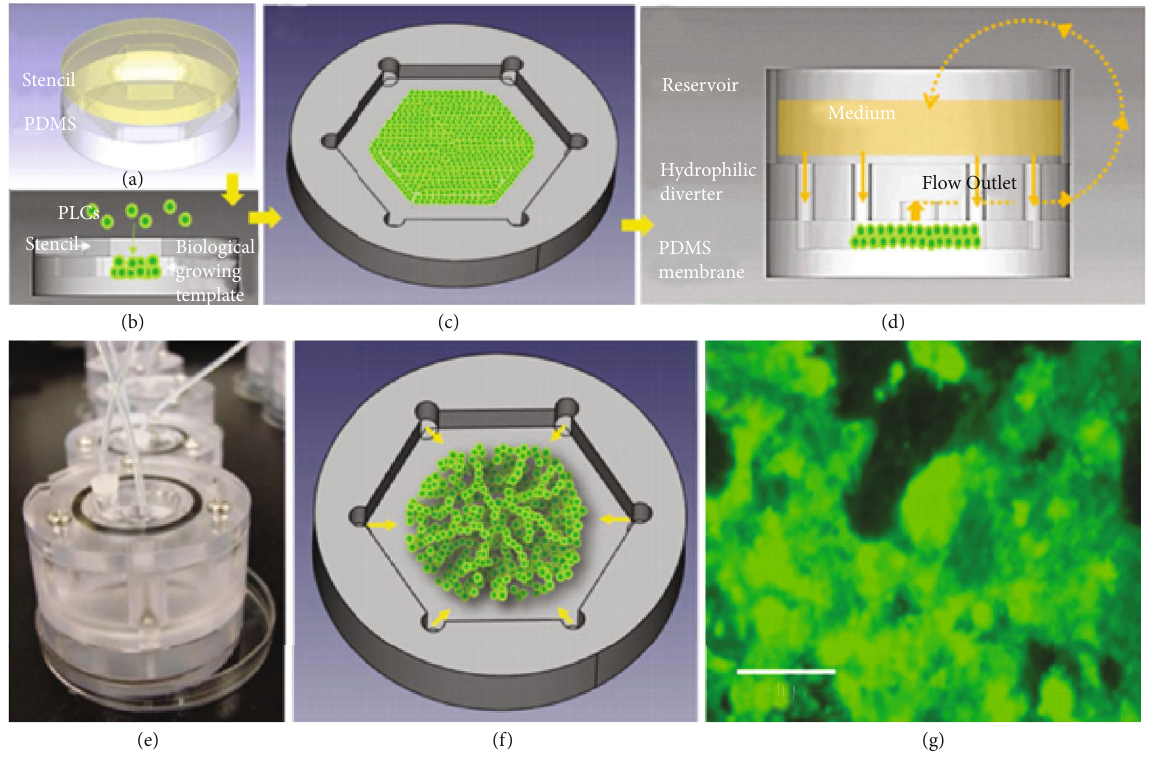
Figure 5: Design principles of a tissue incubator. Multilayered PLCs were deposited on PDMS membrane through a stencil (a) to create a biological growing template (b) and a hexagonal contour (c). After overnight culture, the stencil was removed, and a hydrophilic diverter was assembled with a reservoir to create micro-/macrocirculation (d). The hydrophilic diverter provides PLCs with vertical anchorage. (e) Photograph of the entire device. (f) Schematic diagram of the radial fl ow. (g) Liver-on-a-chip (LOC) shows the cell viability (green). Reproduced (or adapted) with permission [42], ©2017, Wiley Online